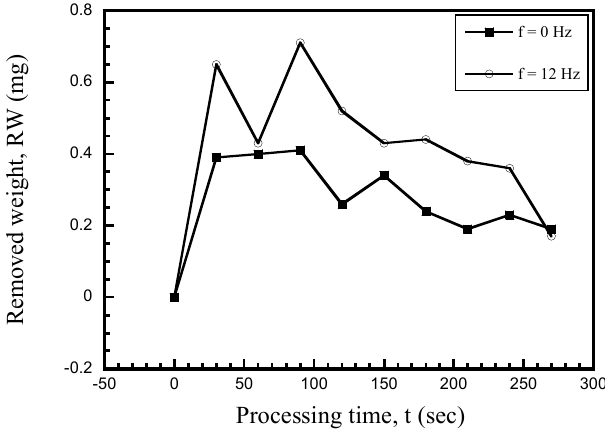
Figure 10. Variations of removed weight against processing time.